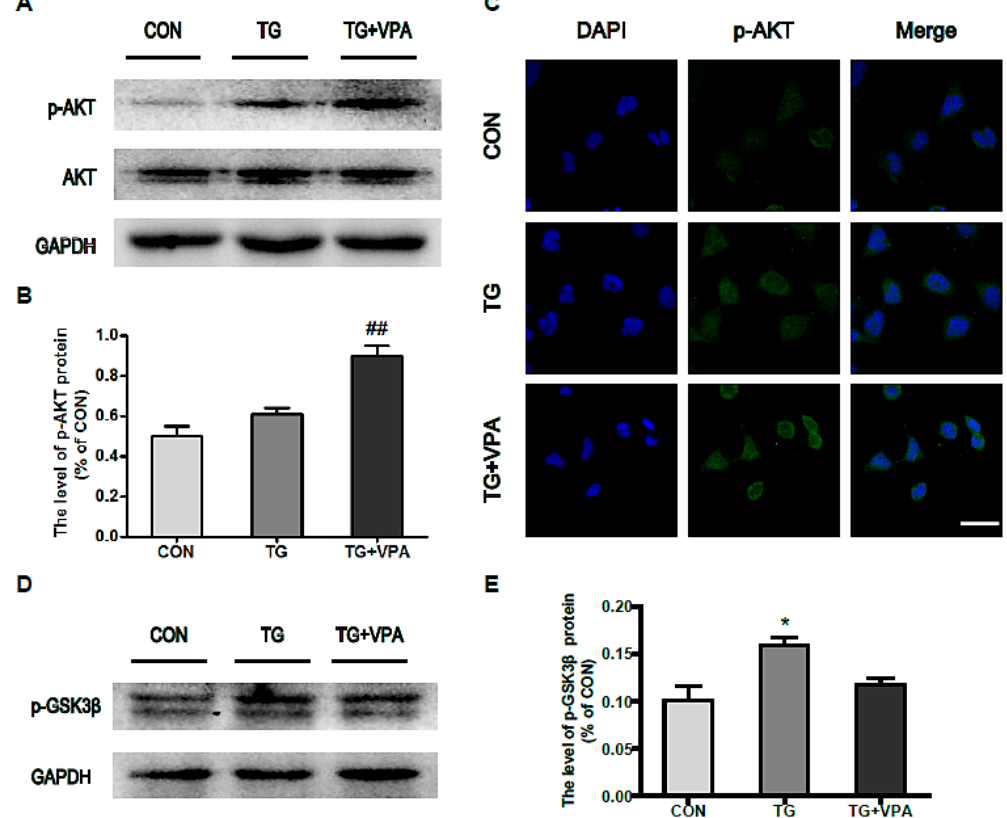
Figure 6. VPA activates the PI3K/Akt/GSK3 β signaling pathway in SH-SY5Y cells. ( A ) Protein level of p-AKT in the control, TG, and TG and VPA groups. n = 3; ( B ) The optical density analysis of p-AKT, ## p < 0.01 versus the TG group; ( C ) Immunofluorescence of p-AKT ( green ); the nuclear ( blue ) was labelled with DAPI. Magnification was 40 × ; ( D ) Protein level of p-GSK3 β after VPA treatment; ( E ) Densitometric analyses of p-GSK3 β , * p < 0.05 versus the control group. Data are the mean values ± SEM, n = 3.